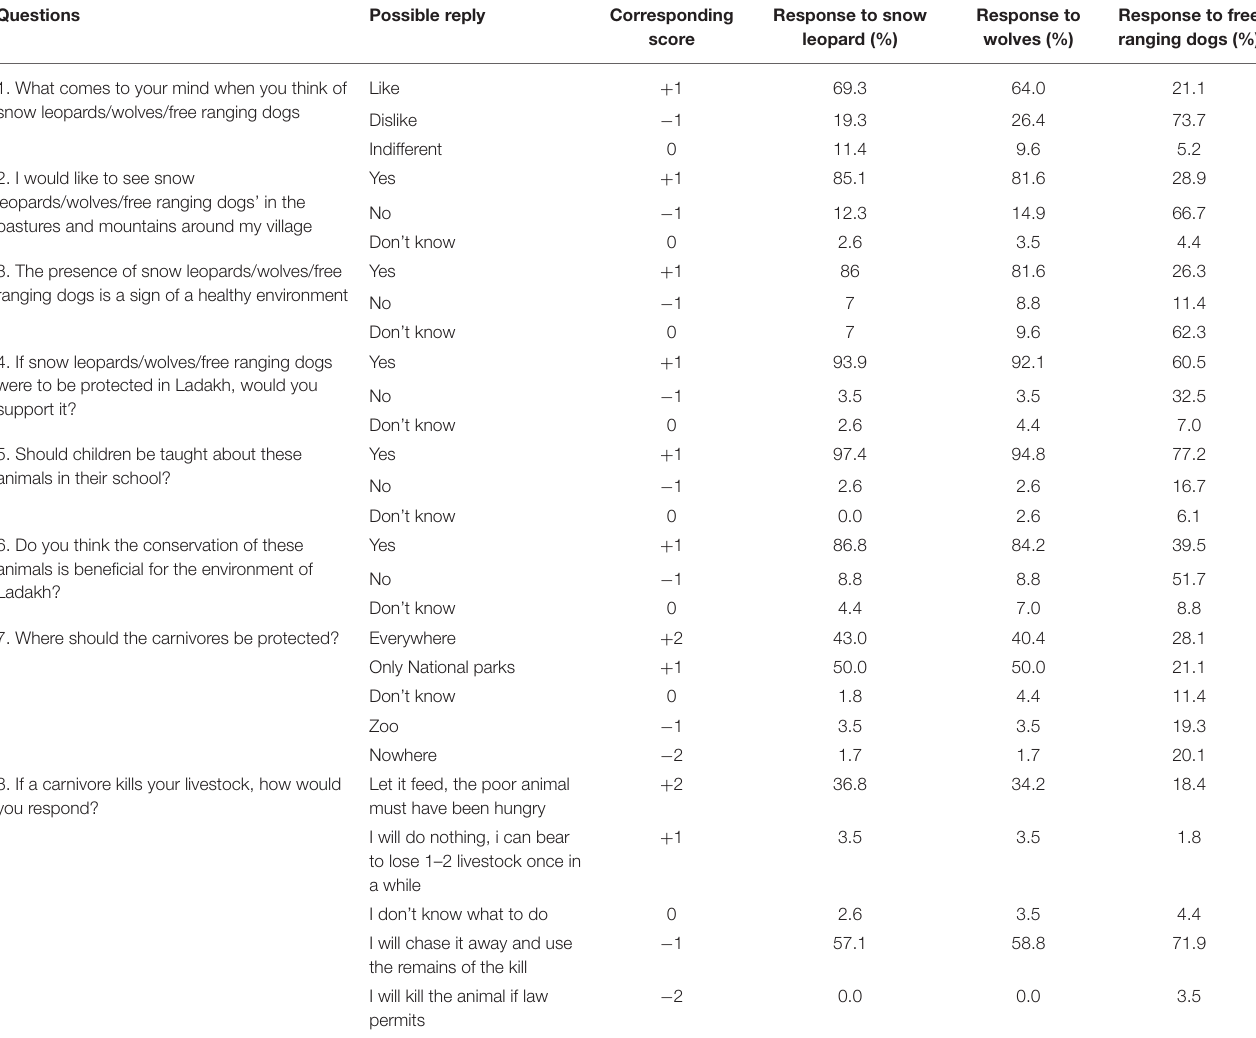
TABLE 1 | Questions along with their corresponding scores used to quantitatively assess the attitudes of local people toward snow leopards, wolves, and free ranging dogs in Leh, 2017.